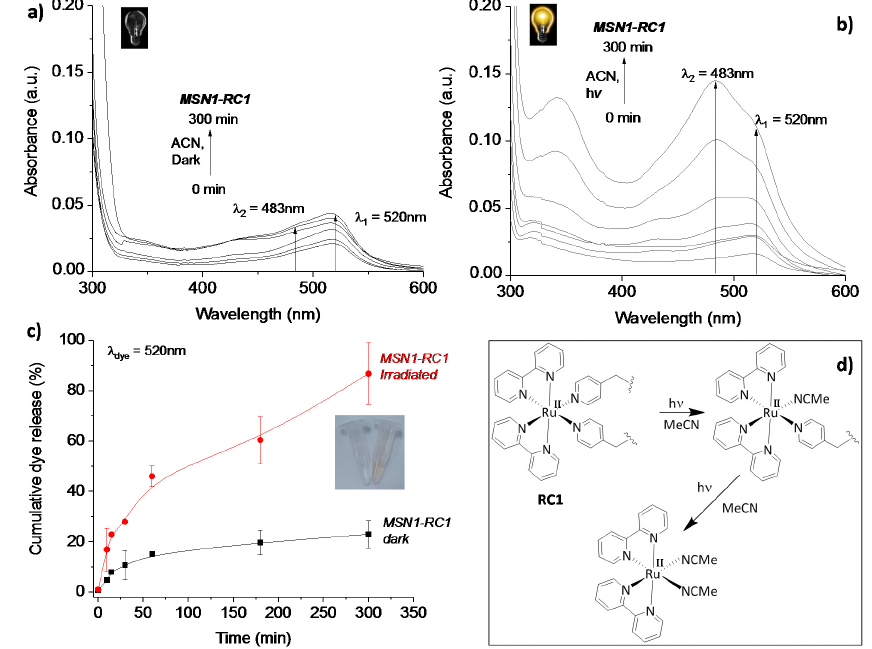
Figure 7. UV-Vis spectra from the release solutions measured from nanomaterial MSN1-RC1 under dark conditions ( a ) and after irradiation ( b ) with an HBO lamp (cut-off >395 nm, in acetonitrile) during 300 min; kinetic profiles of the released solutions of the safranin O at 520 nm before and after irradiation for 300 min ( c ); inset ( c ): Images of the solutions after 300 min of irradiation ( right : pink-orange solution) or under dark conditions ( left : colorless solution); schematic drawing of the photochemical cleavage of both pyridine ligands in acetonitrile which are linked to the silica surface of the nanoparticles ( d ).